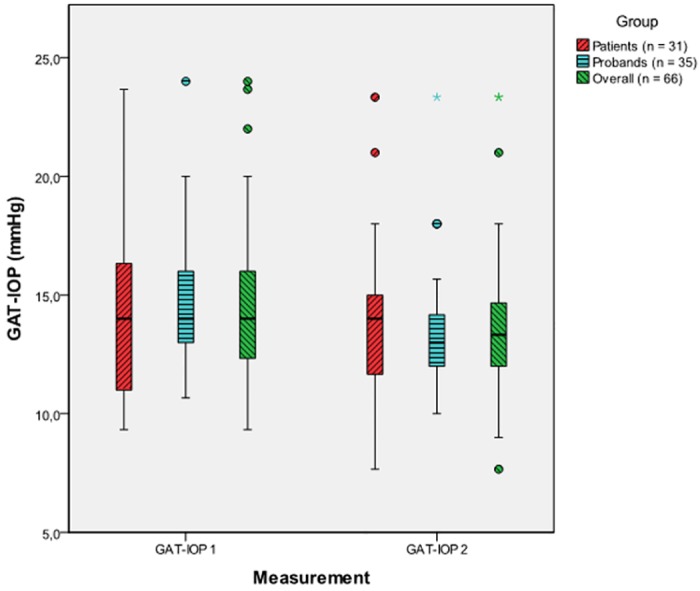
Tonographic effect from the first (GAT-IOP 1) to the second (GAT-IOP 2) GAT measurement for patients, probands and the overall sample (patients and probands combined), [mmHg].